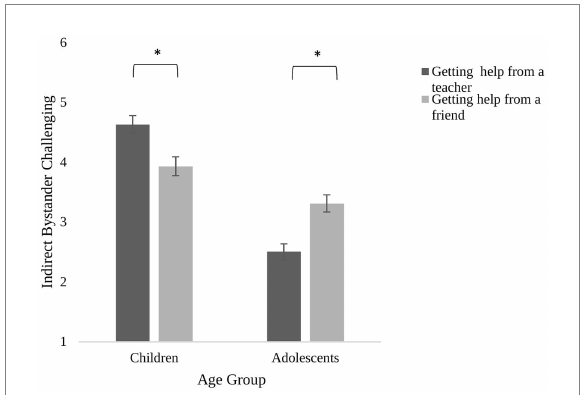
FIGURE 1 Participants’ indirect bystander challenging as a function of age group. Error bars show standard error. * p < 0.001.